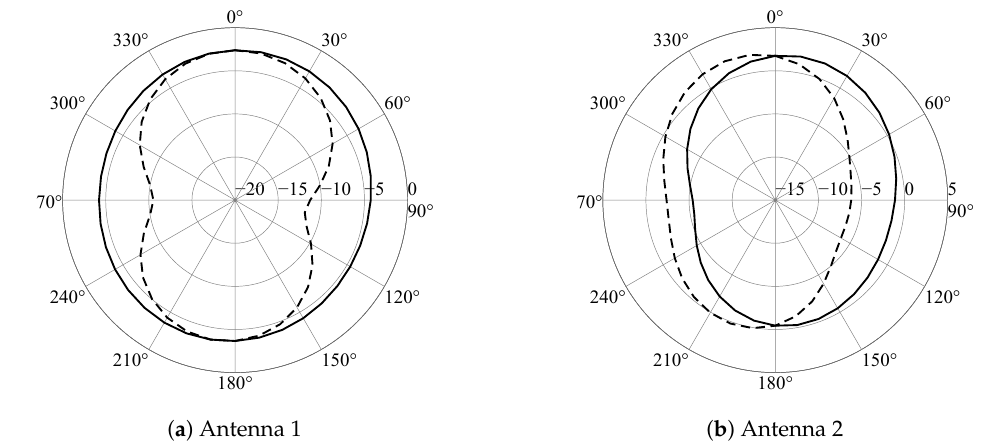
Figure 9. Realized gain of the antennas with φ = 0 ◦ (solid line) and φ = 90 ◦ (dashed line) for Configuration 1.